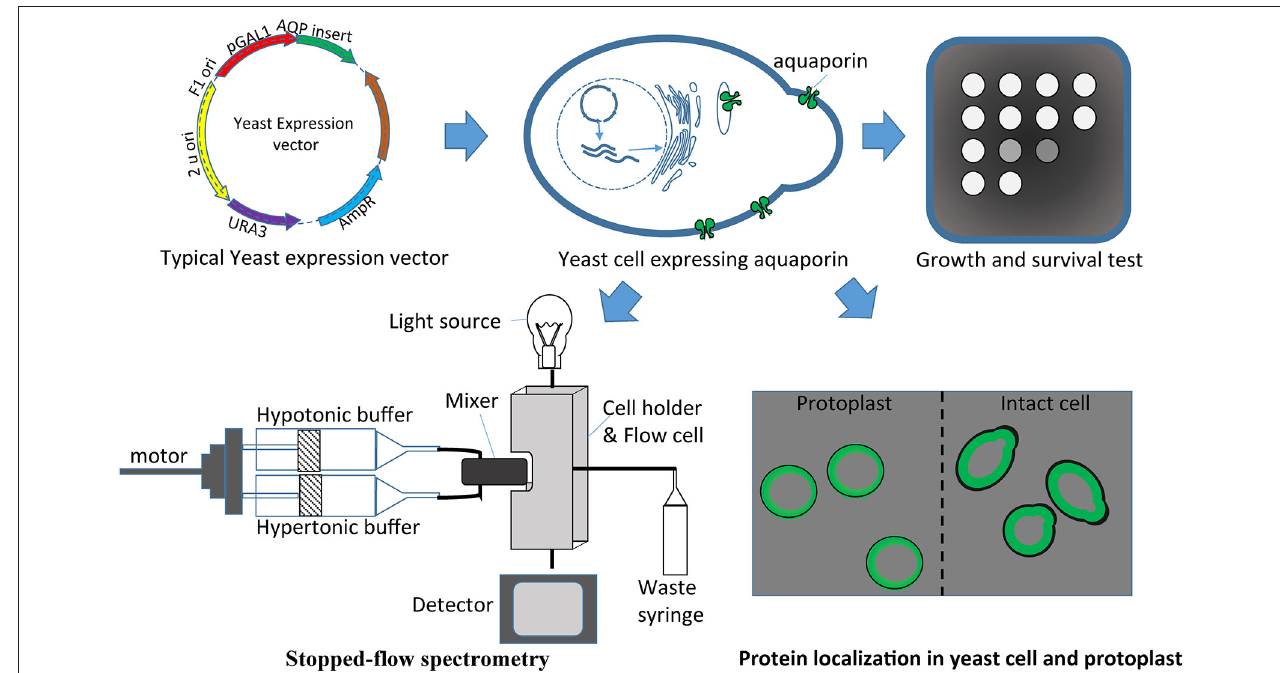
FIGURE 3 | Yeast heterologous expression system used to evaluate aquaporins. Aquaporin cloned in the expression vector can be easily transferred in yeasts for different assays like growth and survival tests, protein localization, and/or stopped-flow